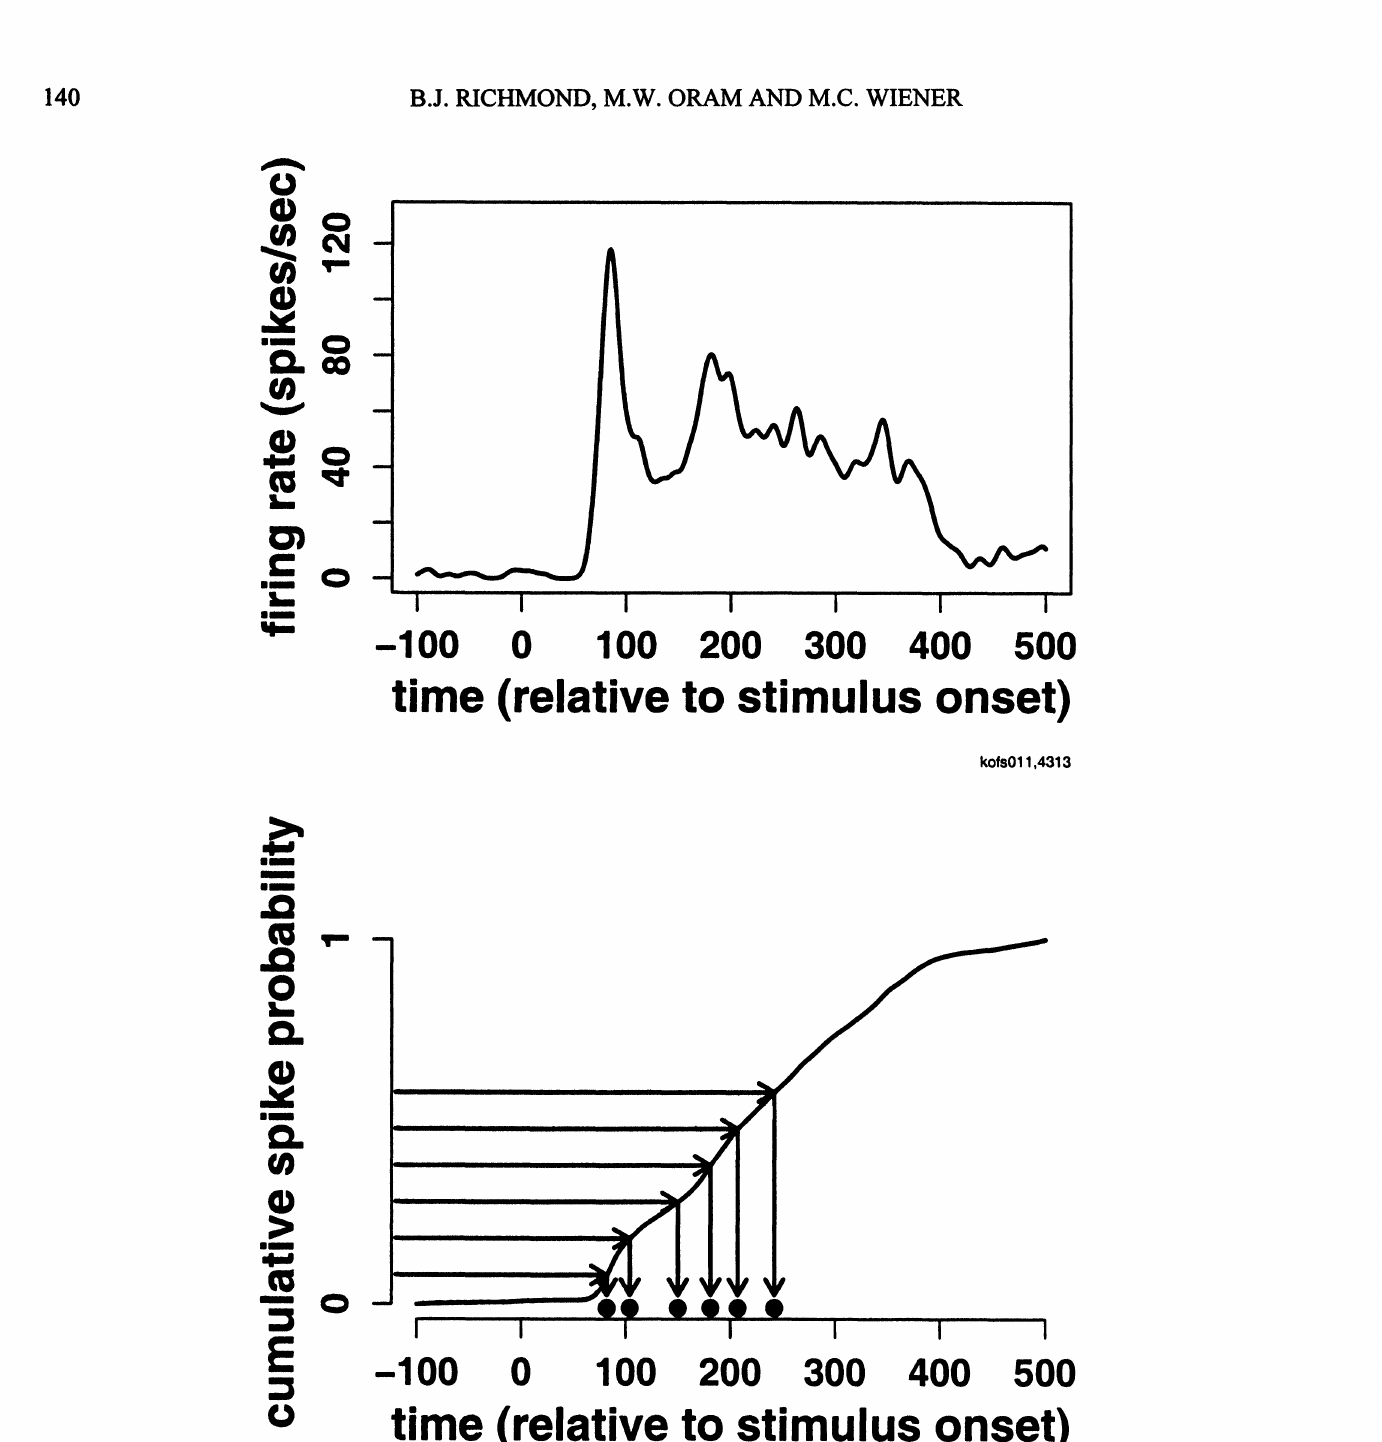
Fig. 4: Spike count matched model. Spike trains are generated so that there is one simulated spike train to match each train in the data, with the spike count in the simulated train being forced to be equal to the corresponding train in the data. The top panel shows the average spike density plot for the responses of one V supragranular compex cell aligned at the time of stimulus onset. This is integrated over the whole period to give the curve in the lower panel. This integrated spike probability density function is then used to generate simulated spike trains using a uniform random number generator. The number of spikes needed is chosen from the number of spikes in the recorded data. In this example, six spikes were needed, so six random numbers would be chosen, placed on the ordinate and mapped through the cumulative spike density function as shown to generate the simulated spike train indicated by the dots at the bottom. For illustration here, six numbers separated by equal intervals were used. After transformation through the cumulative probability function the intervals are no longer equal. Using this procedure places the spikes stochastically due to the random numbers. However, the probability density function averaged across many examples will be indistinguishable from that in the upper